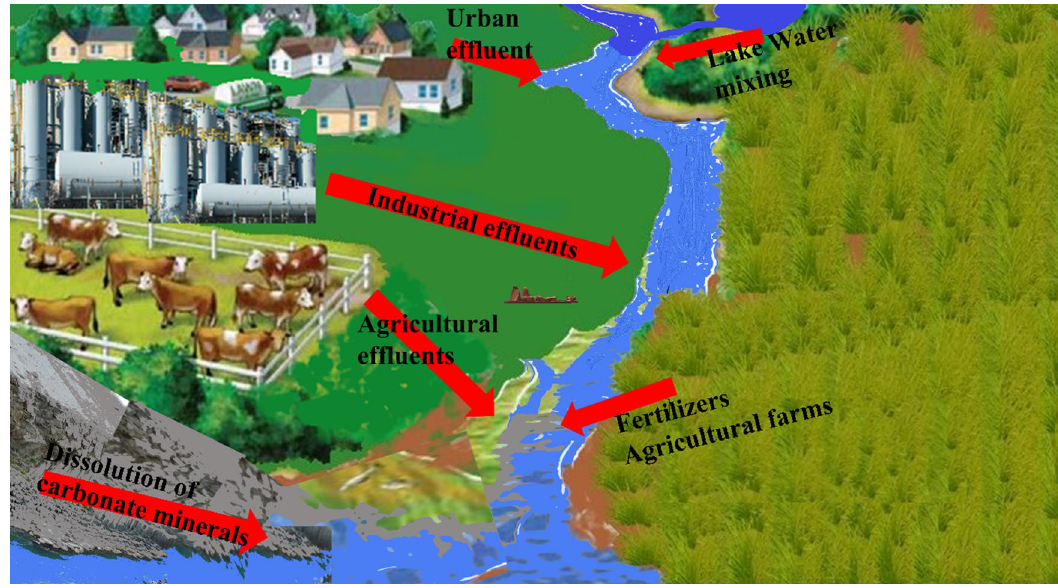
Fig. 9 Conceptual diagram of potential urban, industrial and agricultural effluents as sources of river water pollution. This conceptual diagram was developed using Adobe Illustrator